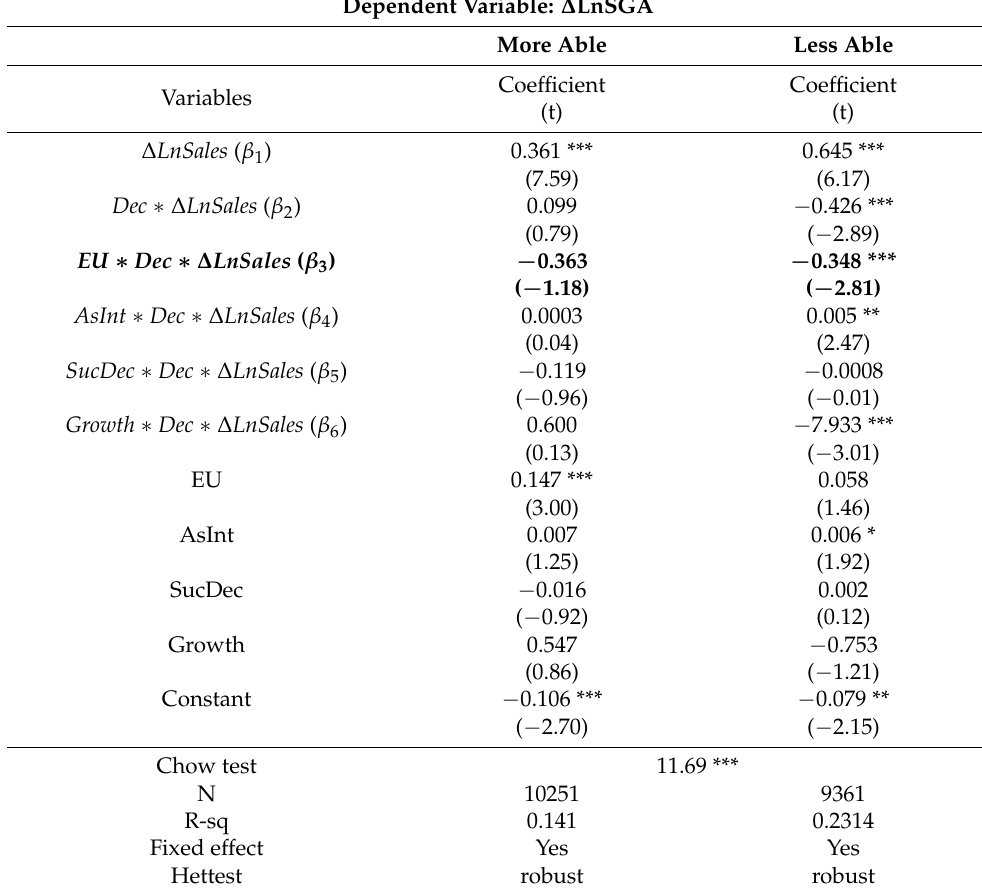
Table 7. Results of the Regression Analysis: Hypothesis